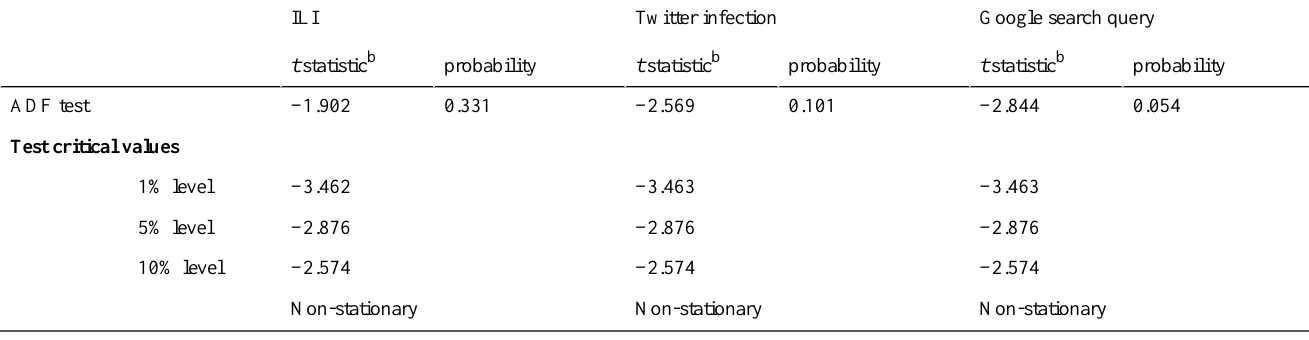
Table 2. Augmented Dickey-Fuller (ADF) test of ILI a , Twitter, and Google search query data.